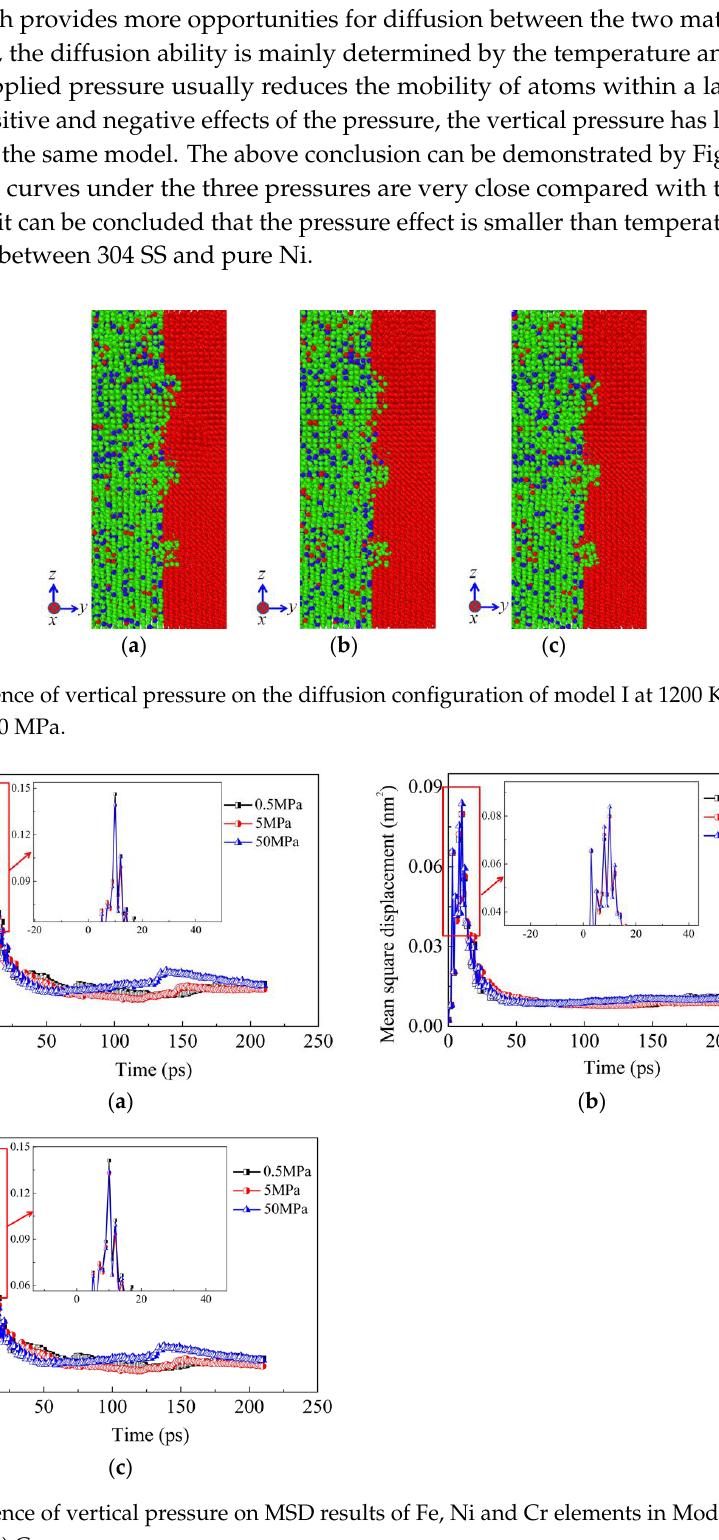
Figure 9. Influence of vertical pressure on MSD results of Fe, Ni and Cr elements in Model Ι at 1200 K: ( a ) Fe; ( b ) Ni; ( c ) Cr.